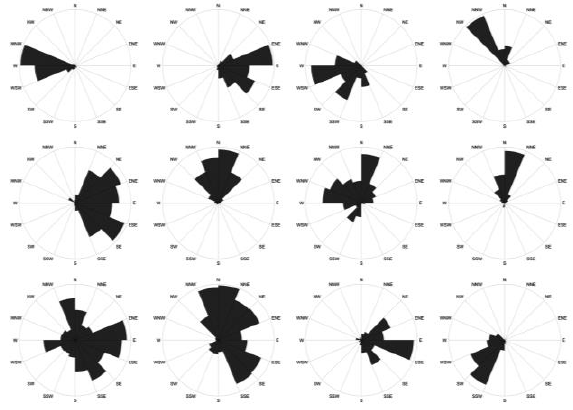
Figure 6 . Per-minute wind-rose of 12 stations in January, 2020 To summarize, high-granularity temporal variations of PM concentrations in fixed near-surface stations are the mixed result of meteorological factors, local terrain, emission processes at various distances and with various durations, and equipment errors and other unobservable factors. To analyse or